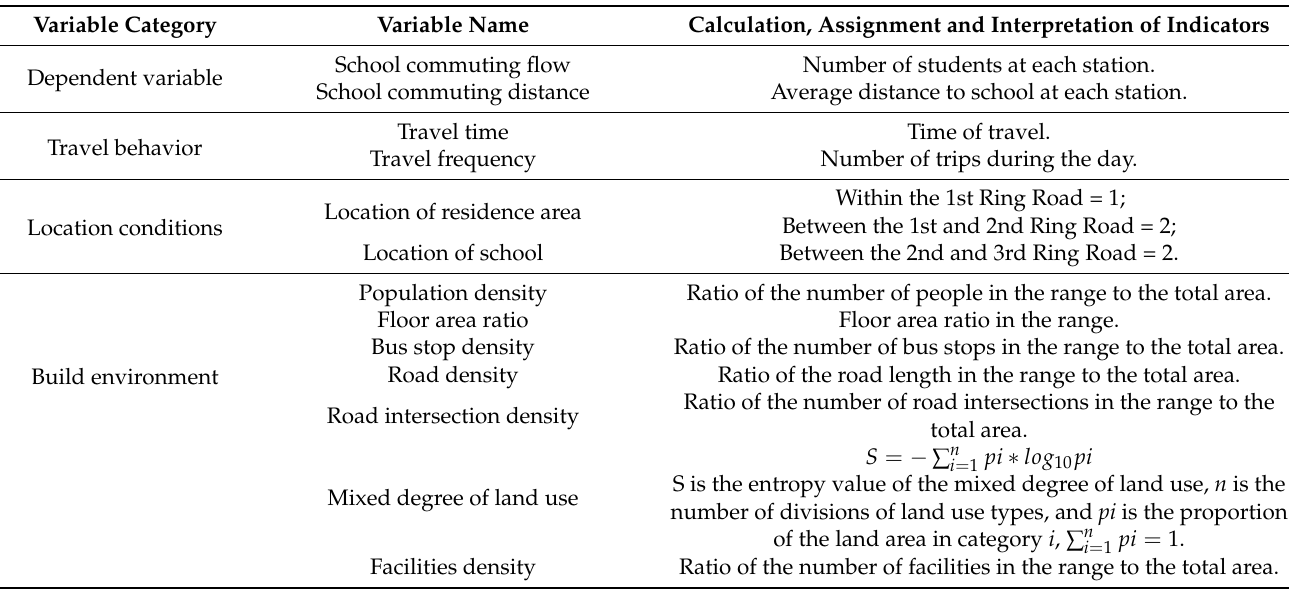
Table 2. Variables and data